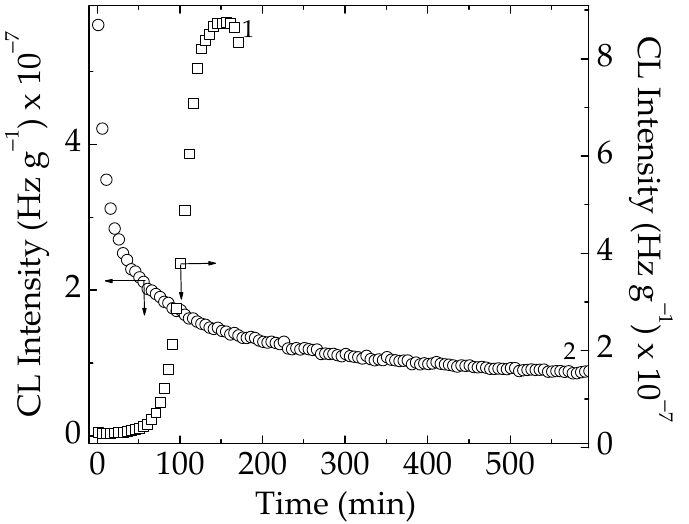
Figure 1. The isothermal chemiluminescence spectra recorded on two polymers with different deg- radation mechanisms. (1) Styrene–isoprene–styrene block copolymer (SIS); (2) poly (lactic acid)